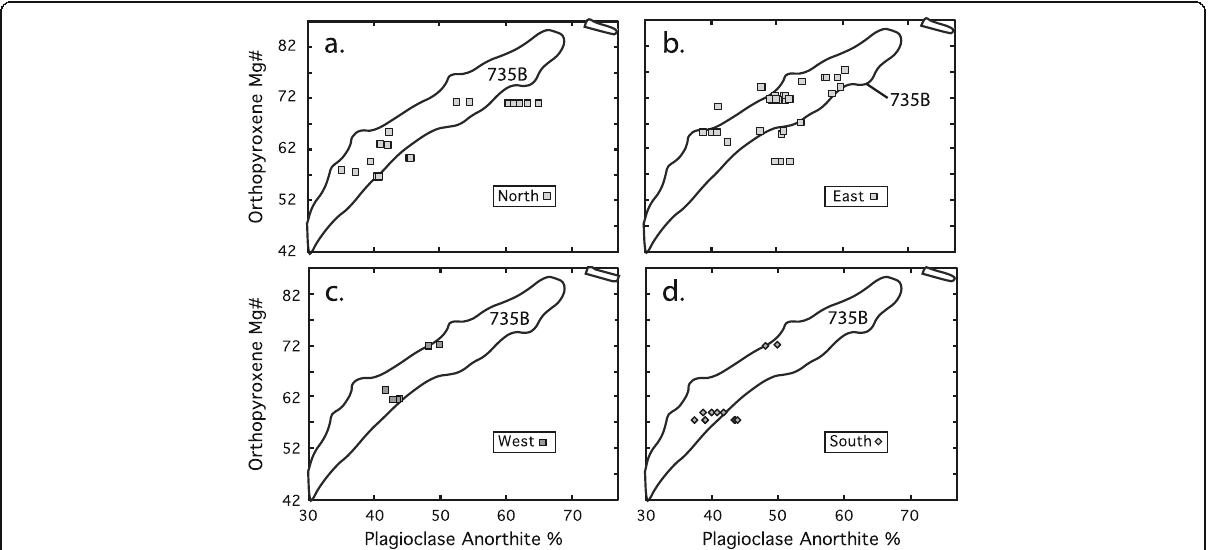
Fig. 18 Atlantis Bank seafloor gabbro orthopyroxene Mg# plotted against plagioclase anorthite content of coexisting Pl and Opx in the Atlantis Bank dive, dredge and core gabbros: a northern region; b eastern region; c western region; and d southern region. The fields represent Hole 735B